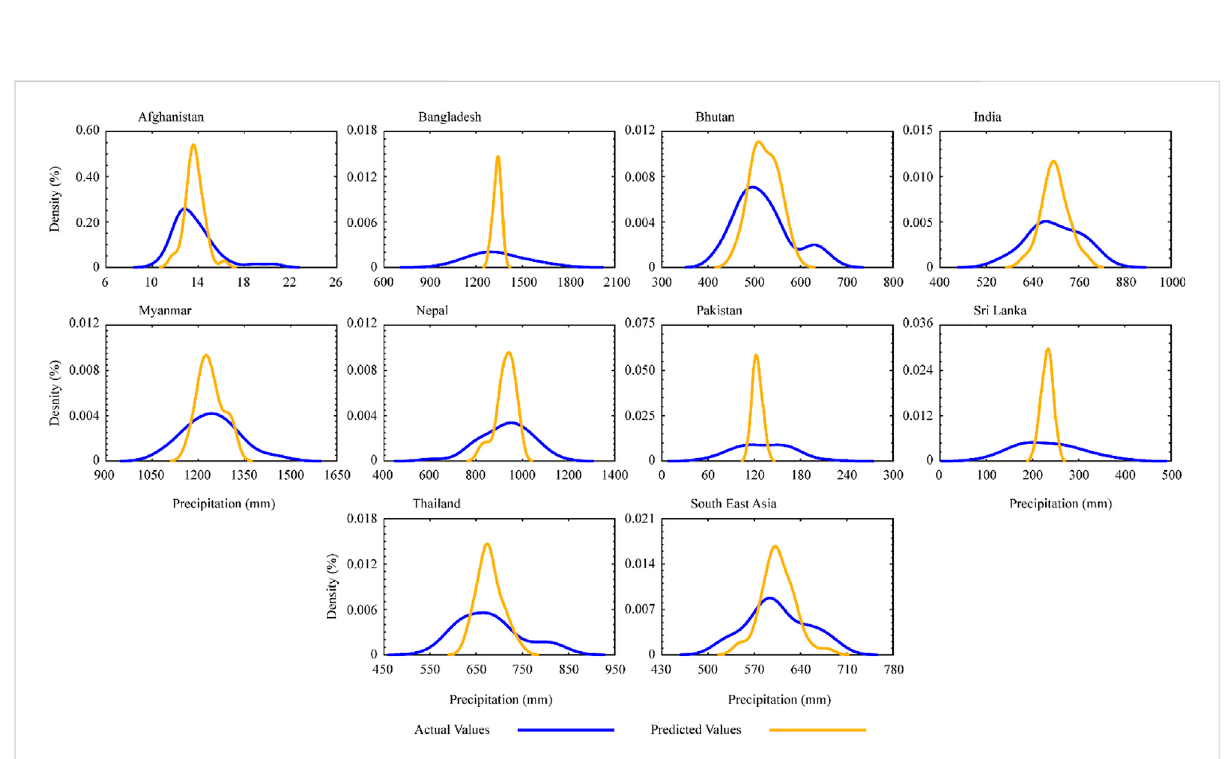
FIGURE 11 Probability distribution function of summer actual and predicted precipitation values during 1981 –